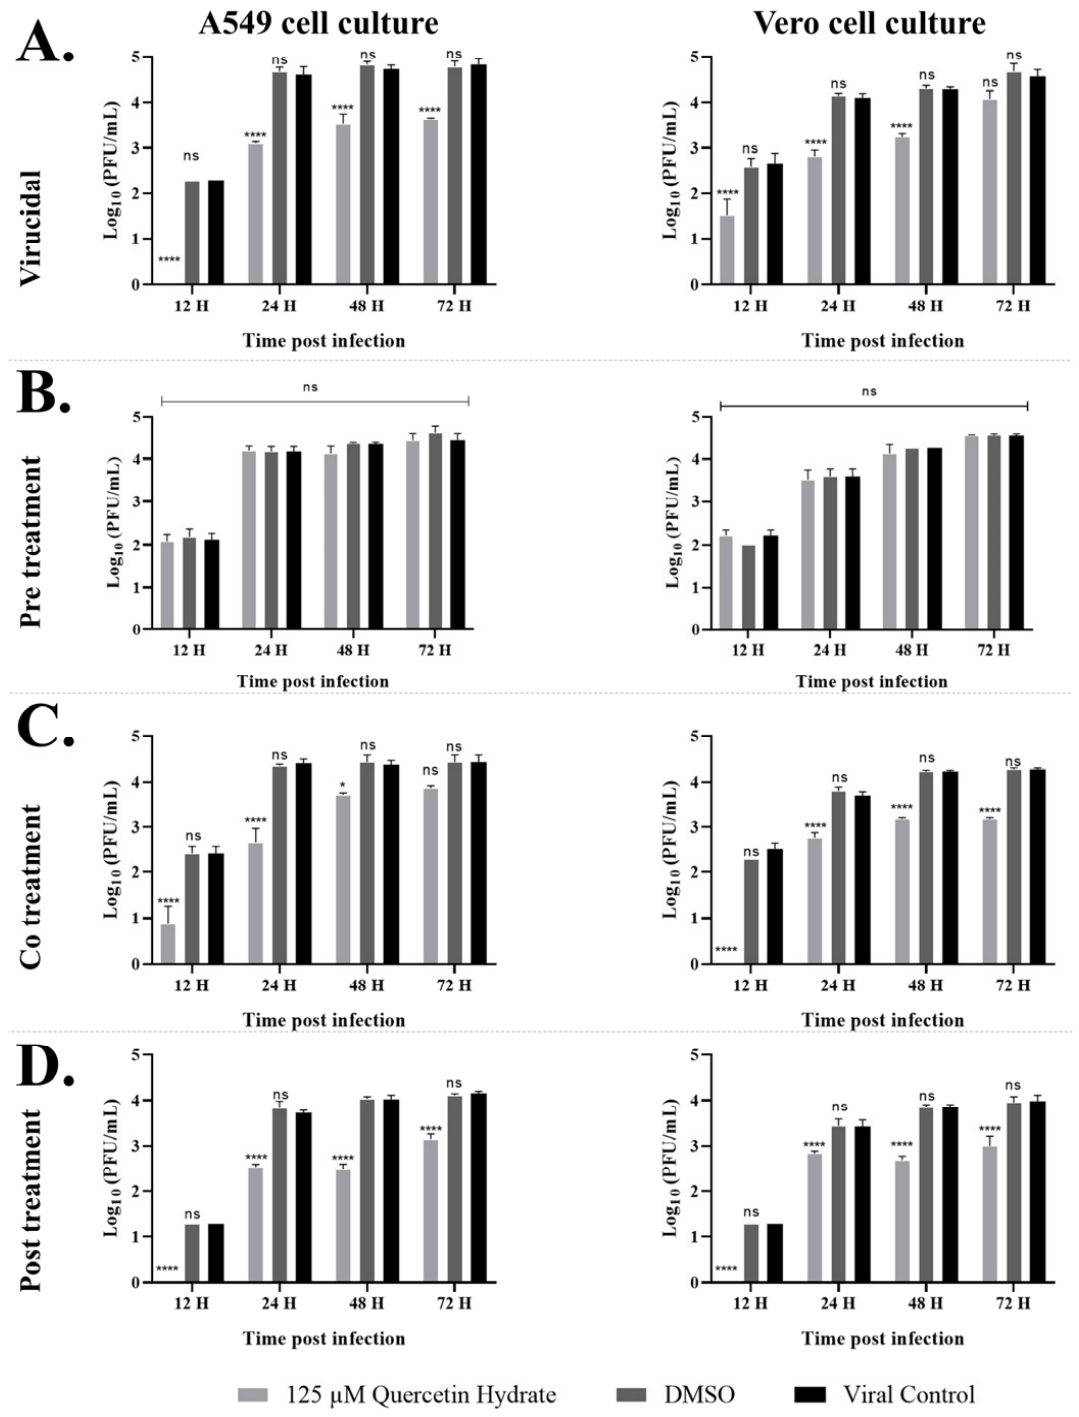
Figure 2. Growth curves of ZIKV (MOI = 0.1) in A549 or Vero cells in the presence of 0.5% DMSO or 125 µM quercetin hydrate, showing impaired ZIKV progeny production after treatment with quercetin hydrate when applied in the ( A ) virucidal assay, ( B ) pre-treatment assay, ( C ) co-treatment assay, and ( D ) post-treatment assay. (*, p < 0.05/****, p < 0.0001/ ns, not